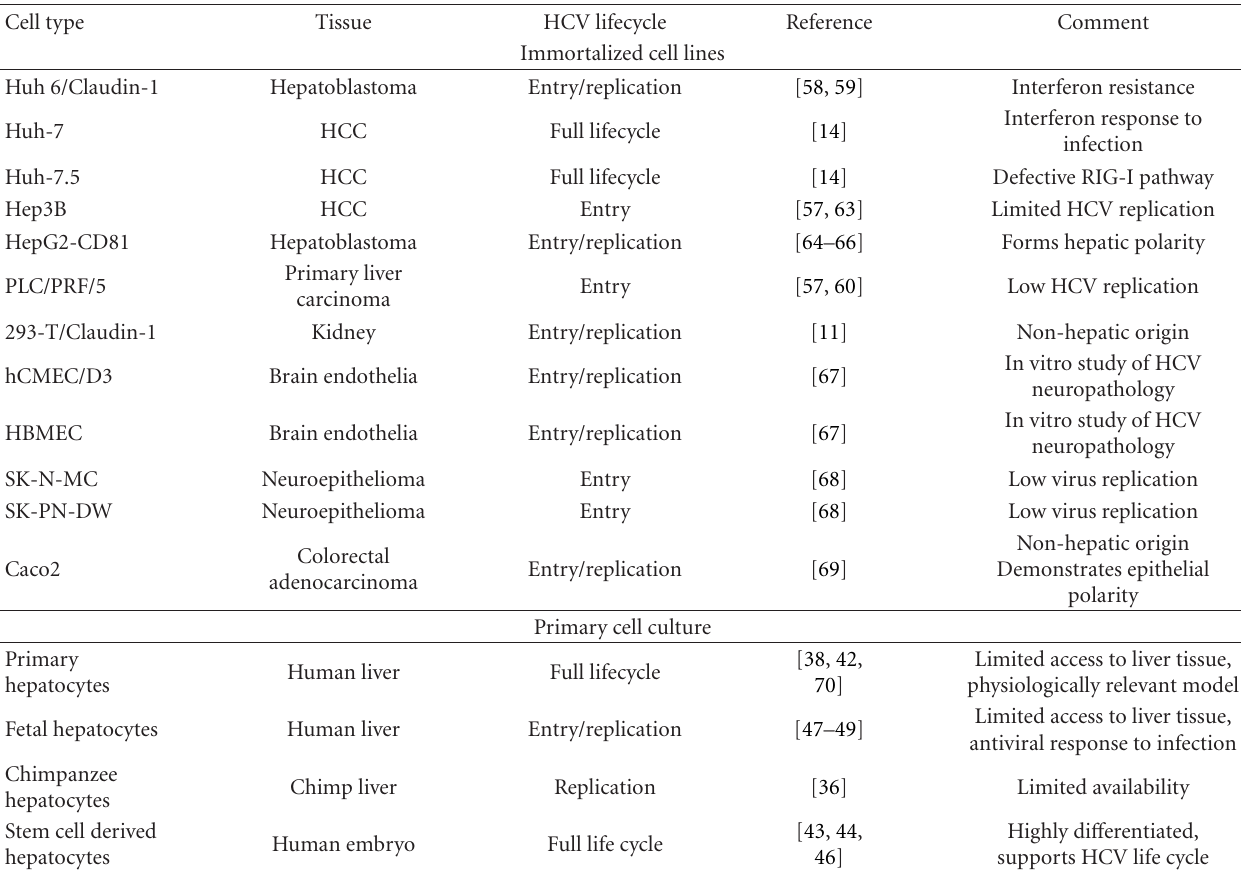
Table 1: Culture models to study the HCV lifecycle. Several hepatic models have been employed to study diverse aspects of the viral lifecycle. Models of nonhepatic origin have also been employed and proved useful in identifying potential extra hepatic sites of HCV infection in vivo. In addition, Caco2 cells were used to study the e ff ects of polarity on HCV infection as most hepatic cell lines fail to polarize in culture. However, a perfect model that closely mimics the in vivo environment is still yet to be